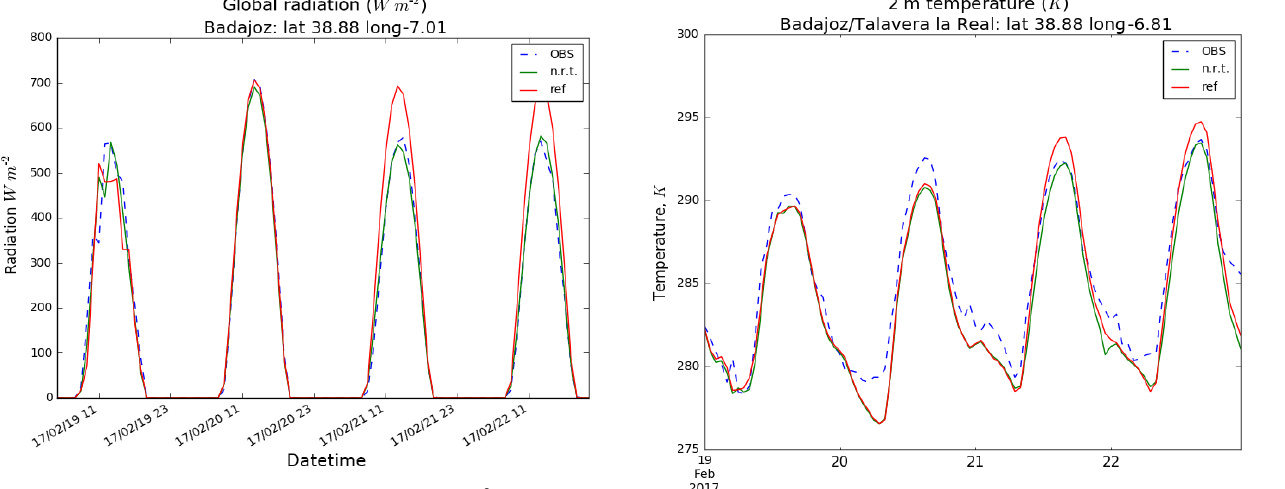
Figure 4. One-hour average global radiation (Wm − 2 ) for Bada- joz station from 19 until 22 February: the default Tegen experiment (red), CAMSNRT experiment (green) and observations (dashed blue).